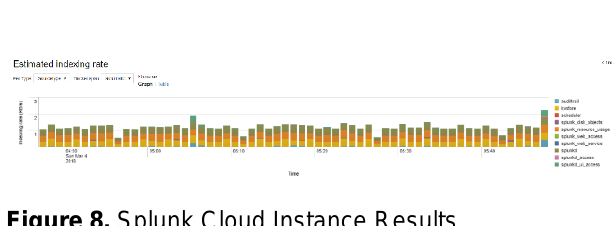
Figure 8. Splunk Cloud Instance